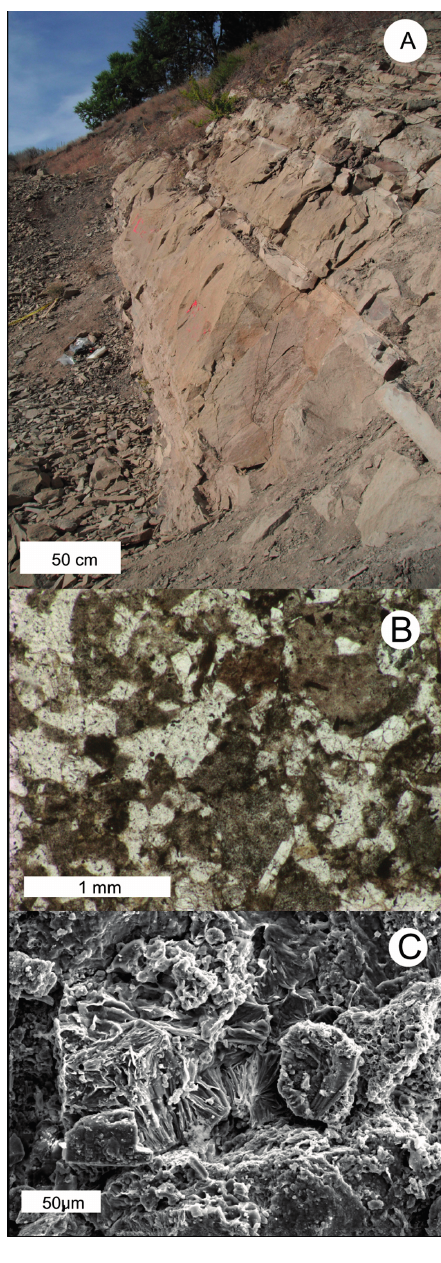
Figure 10. Upper lithic sandstone unit: ( A ) outcrop view; ( B ) thin section view under polarized light; and ( C ) SEM photomicrograph (specimen WWU SR-14). Clasts consist of volcaniclastic